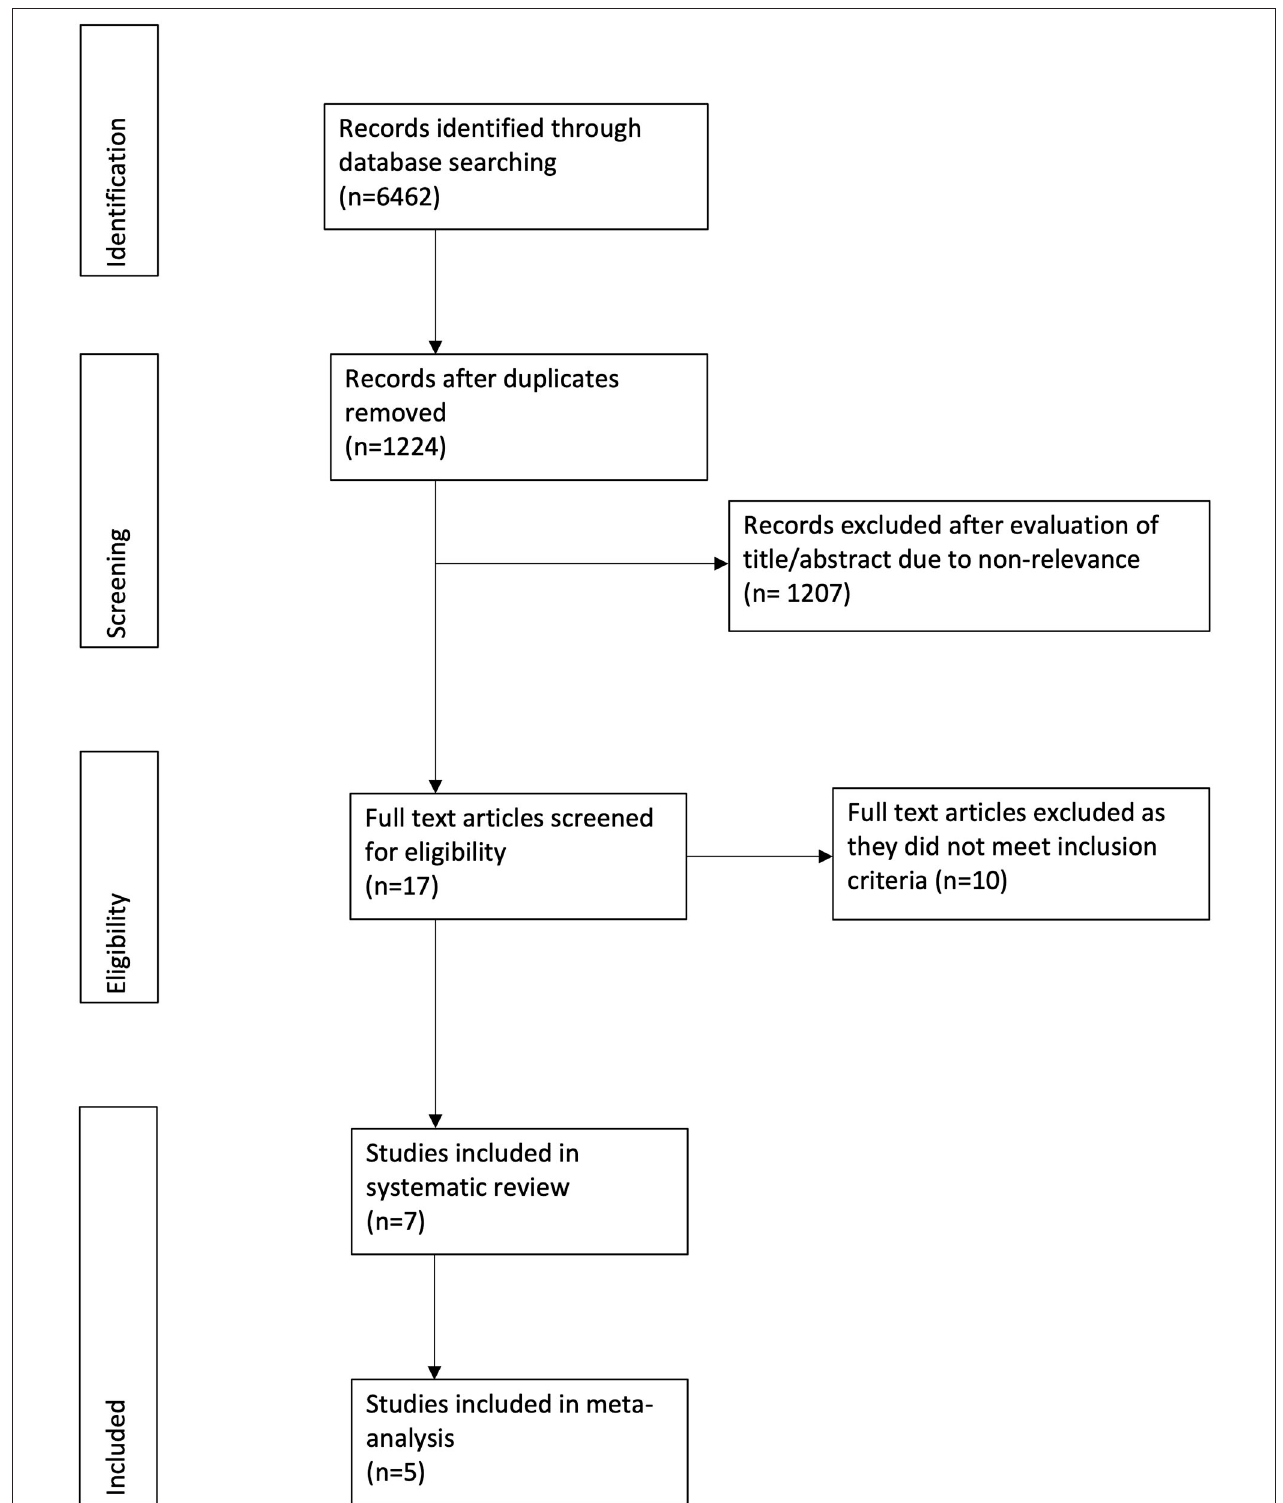
FIGURE 1 | Study flow chart.